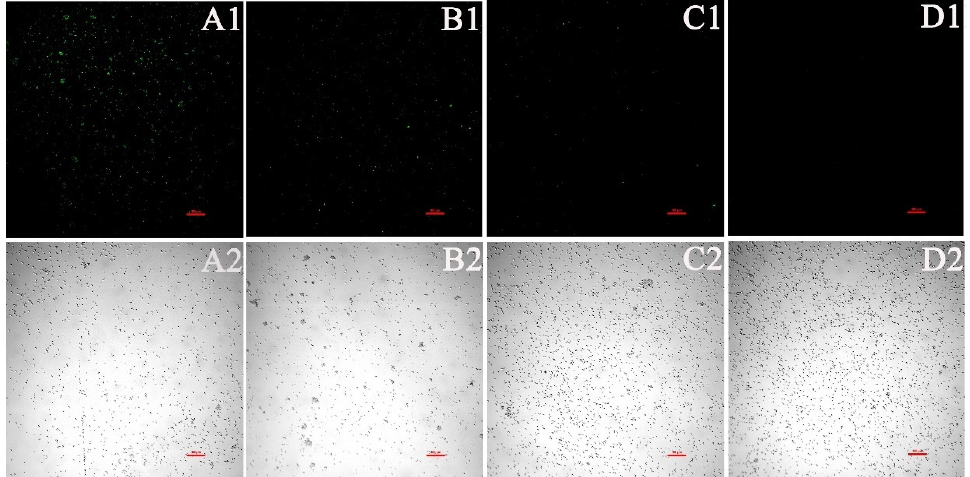
Figure 7. Detection of ROS level in C. albicans by CLSM. ( A1 , A2 ) were treated with 32 µ g/mL EA; ( B1 , B2 ) were treated with 16 µ g/mL EA; ( C1 , C2 ) were treated with 8 µ g/mL EA; and ( D1 , D2 ) were the untreated controls. Scale bars represent 100 µ m.